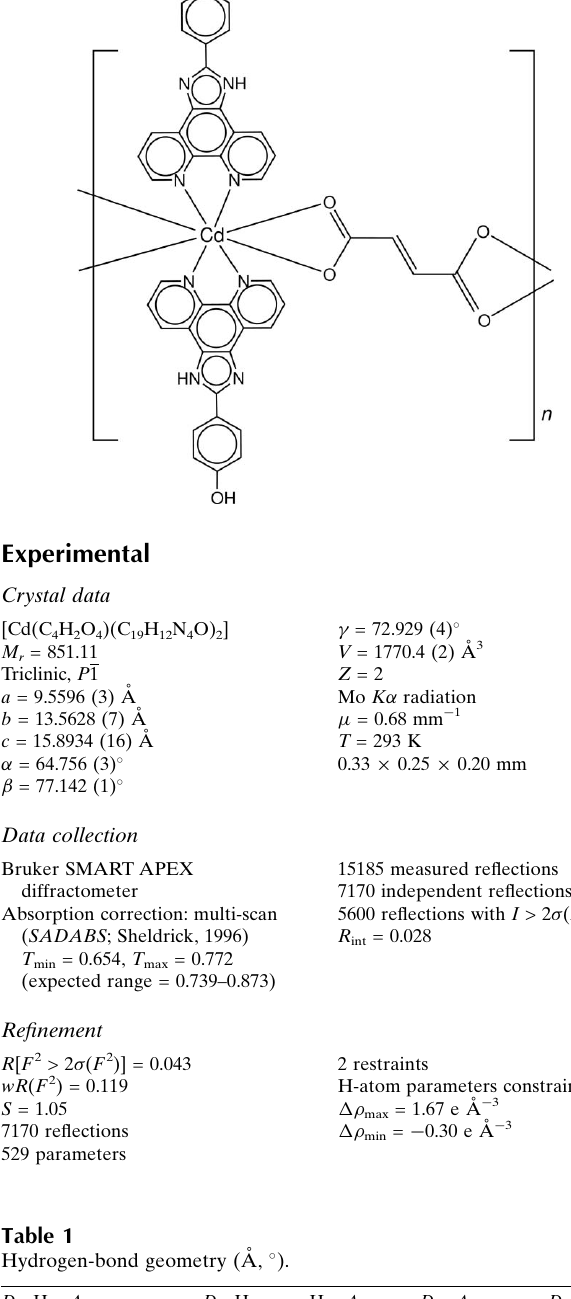
Hydrogen-bond geometry (A˚ , (cid:3) ). D —H (cid:2)(cid:2)(cid:2)